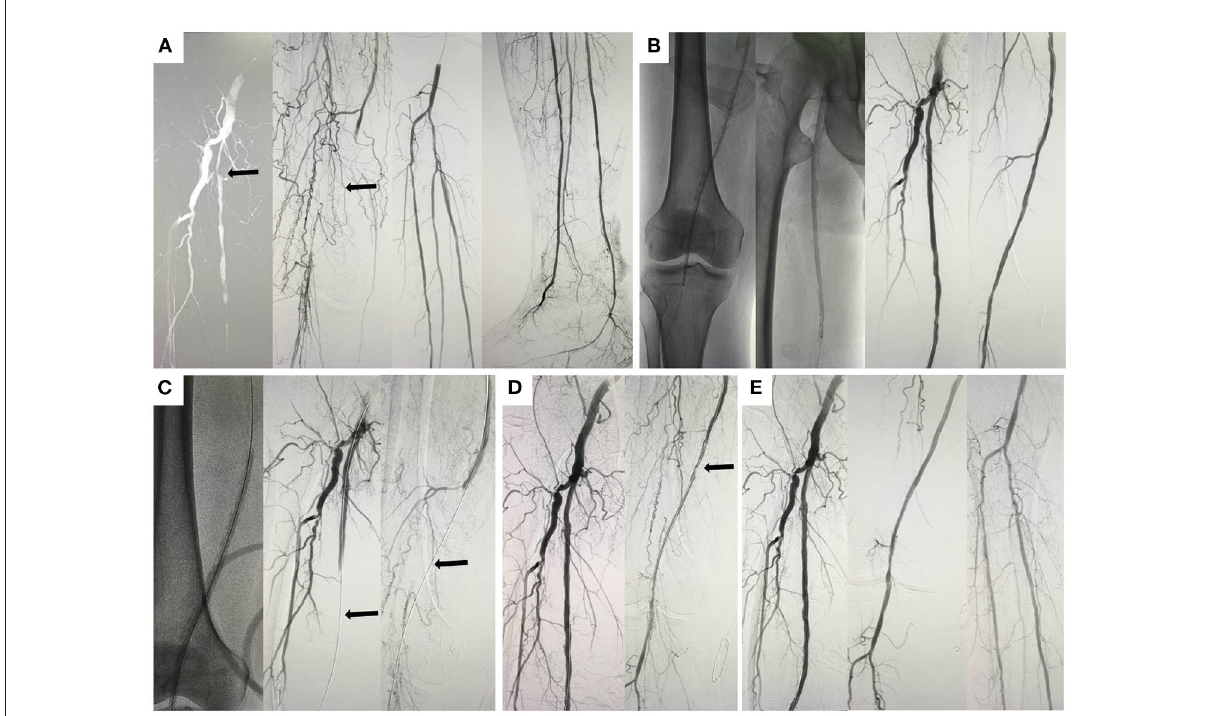
FIGURE1 Angiographic images of the patient. (A) Initial angiography of the target lesion (black arrow); (B) predilation of the lesion and post-dilation images; (C) paclitaxel-coated balloon and the no-reflow phenomenon (black arrow); (D) angiographic images after intravascular therapy (black arrow); (E) final images and blood flow revascularization.